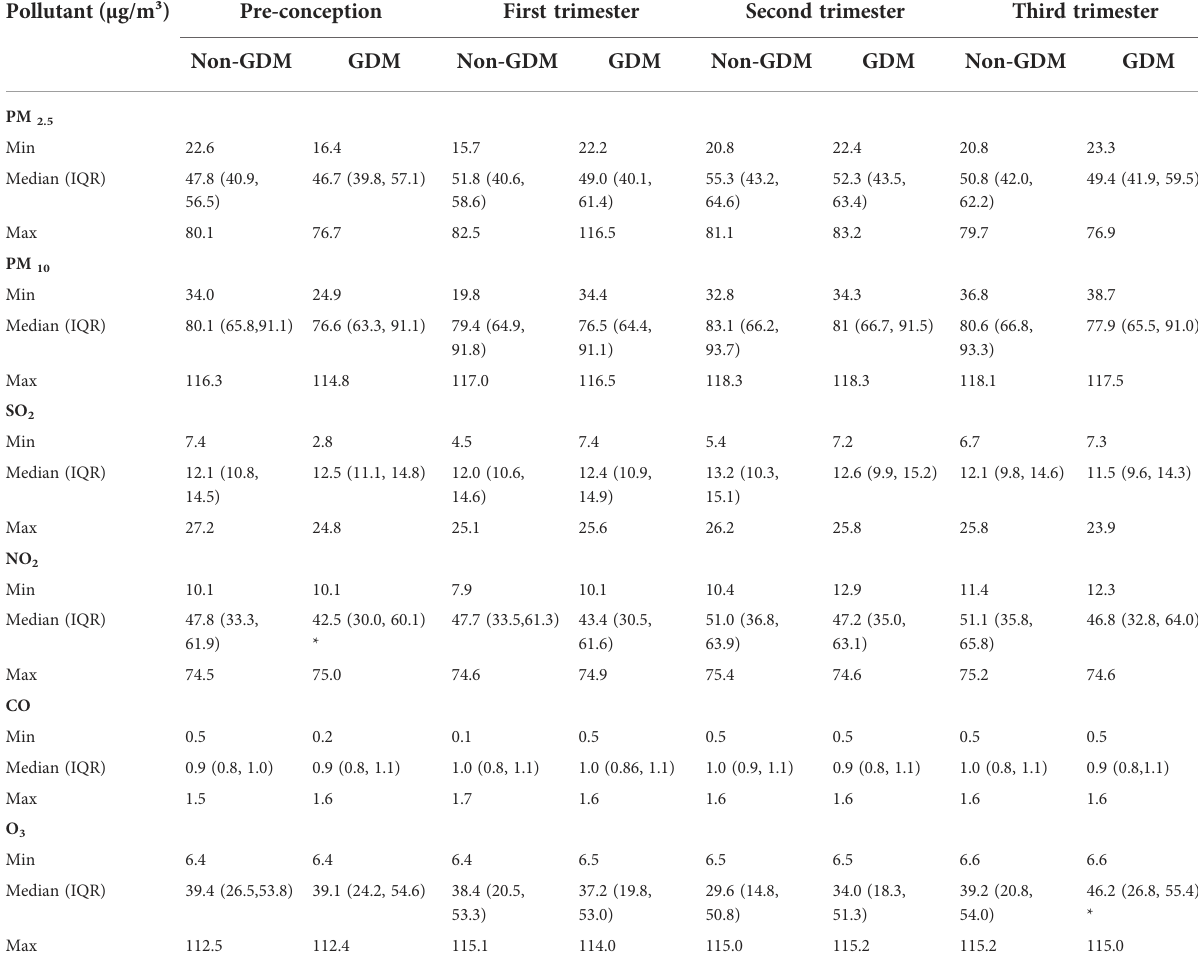
TABLE 3 Daily average concentrations exposure of the pollutants using the proximal model.